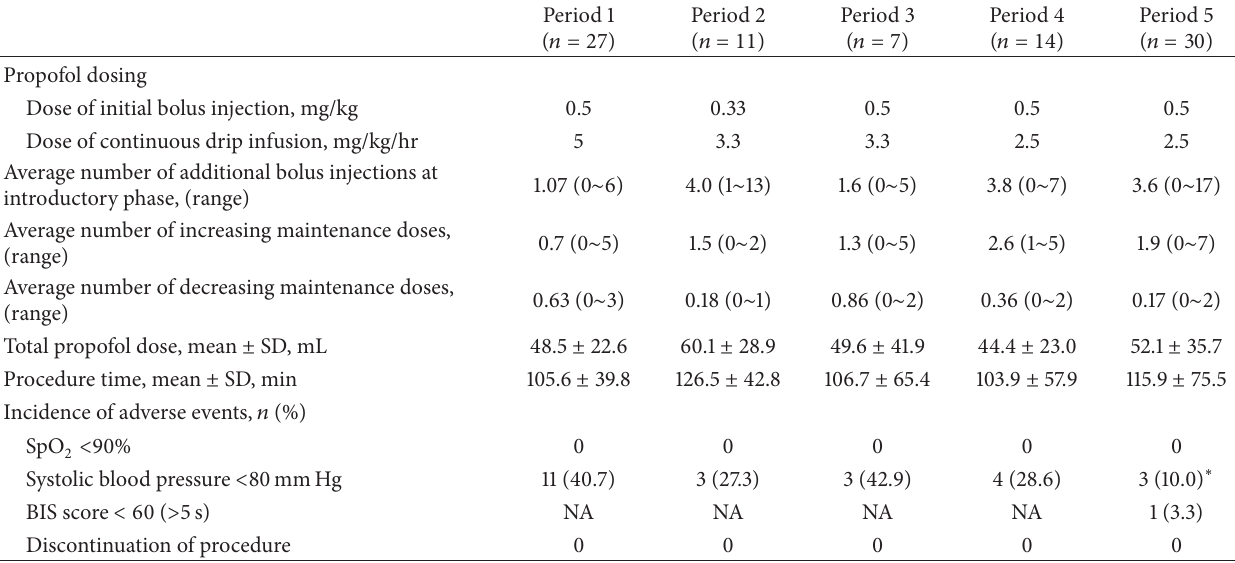
Table 2: Propofol dosages and the incidence of adverse events during each period of the study.